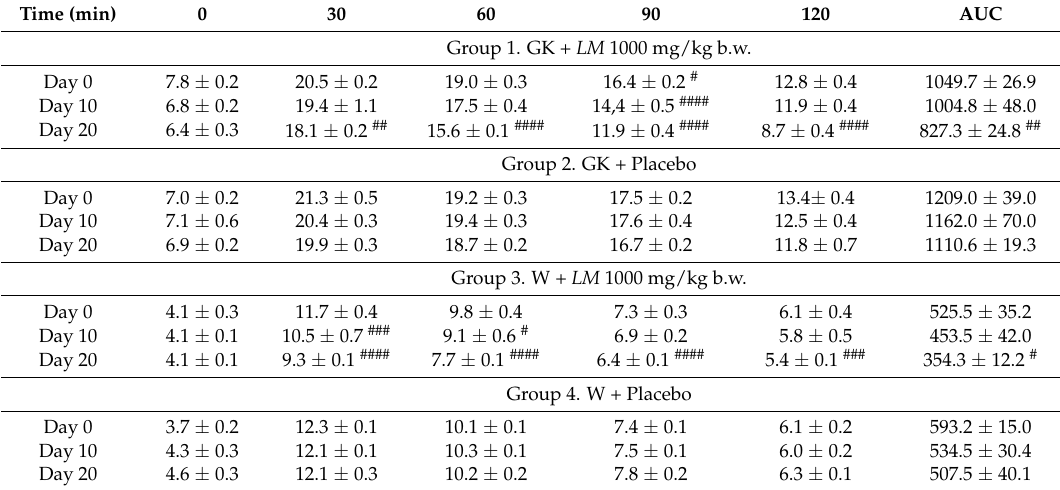
Table 1. Effect of LM long-term treatment on the Oral Glucose Tolerance test performed at 0, 10 and 20 days of treatment in GK and W rats. Values of blood glucose (mM) determined at 0, 30, 60, 90 and 120 min and the area under the curve of glucose (mM/120 min), in each time point, are presented.